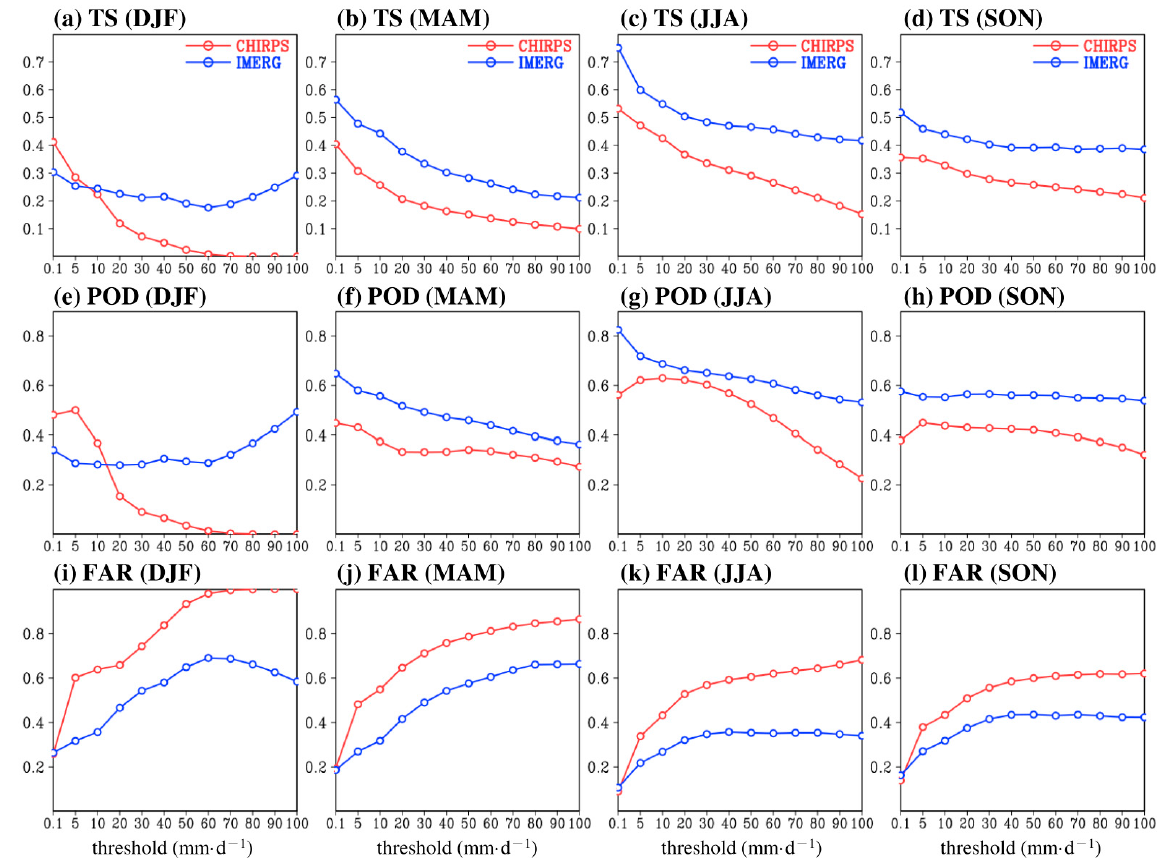
Figure 11. Statistical scores calculated for comparison between CWB and two SPPs (CHIRPS and IMERG) during four seasons of 2001–2019 at different precipitation thresholds. ( a – d ) show values of threat score (TS), ( e – h ) show values of probability of detection (POD), ( i – l ) are the values of false alarm rate (FAR).